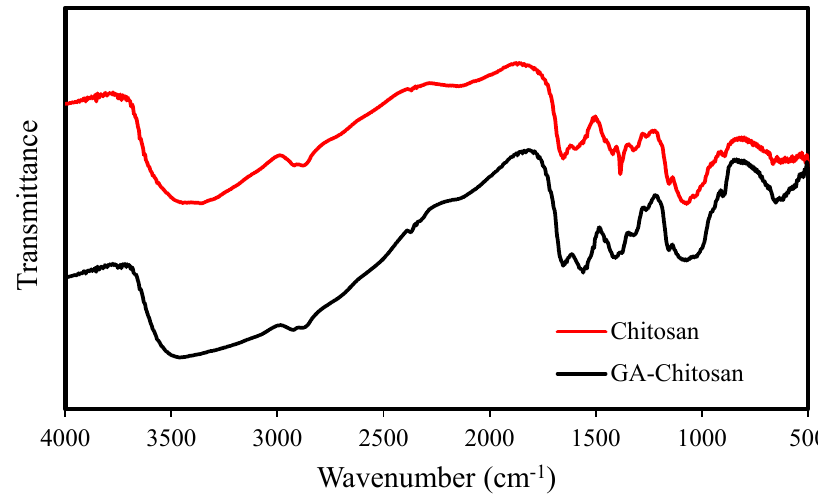
Figure 5. FT–IR spectra of chitosan and GA–chitosan.